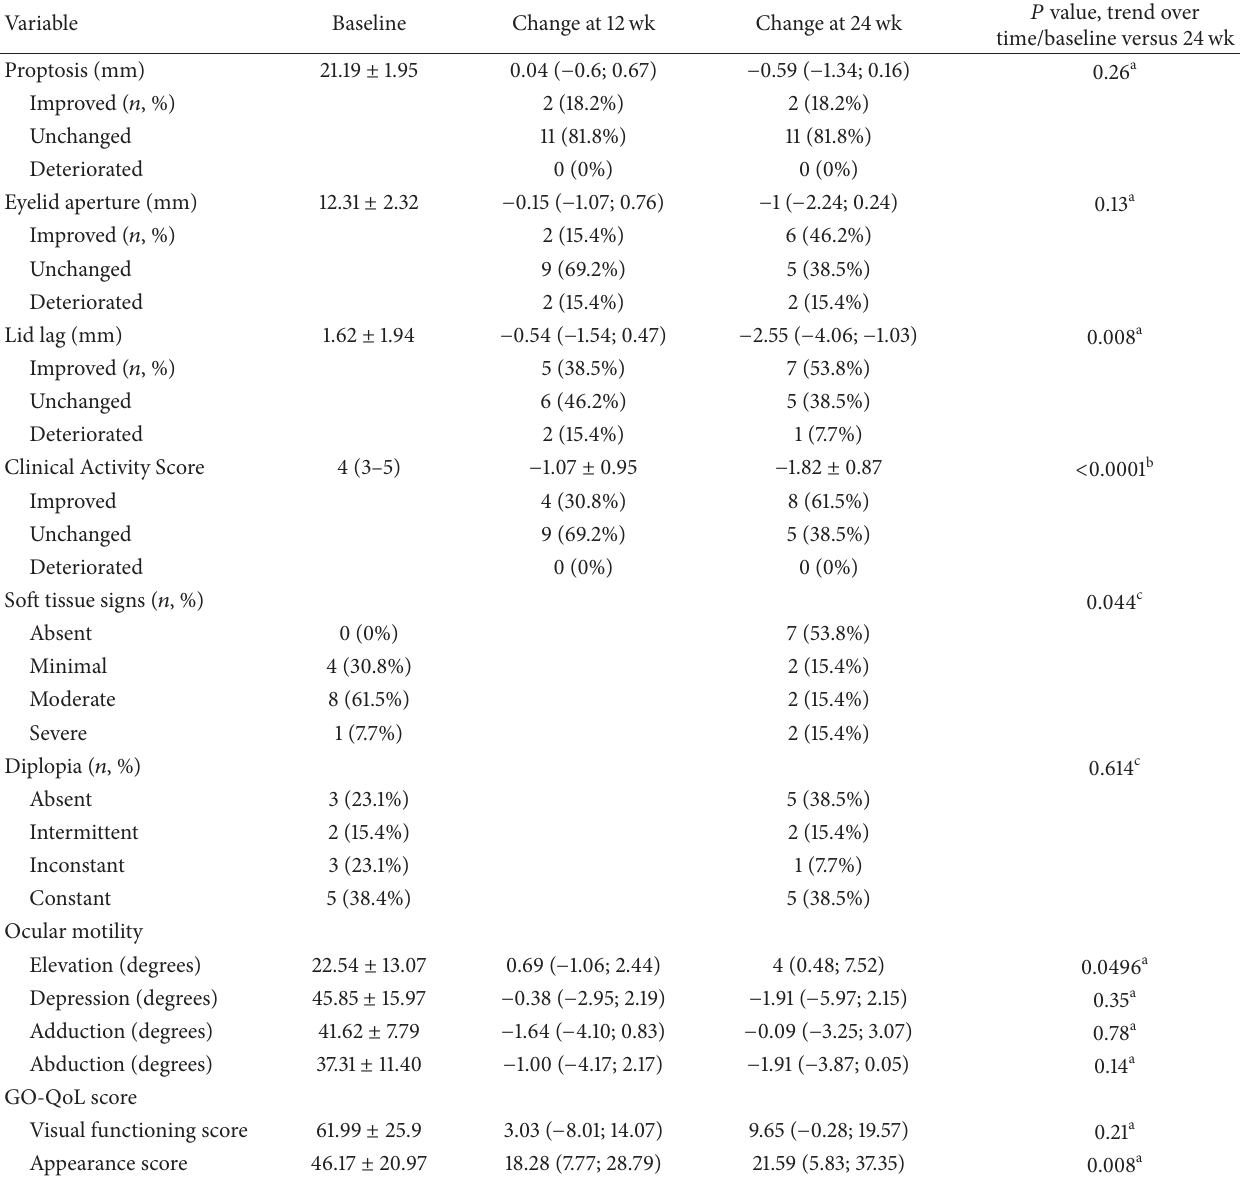
Table 2: Eye signs, Clinical Activity Score, and Graves’ orbitopathy-specific quality of life (GO-QoL) score at baseline and at 12 and 24 wk